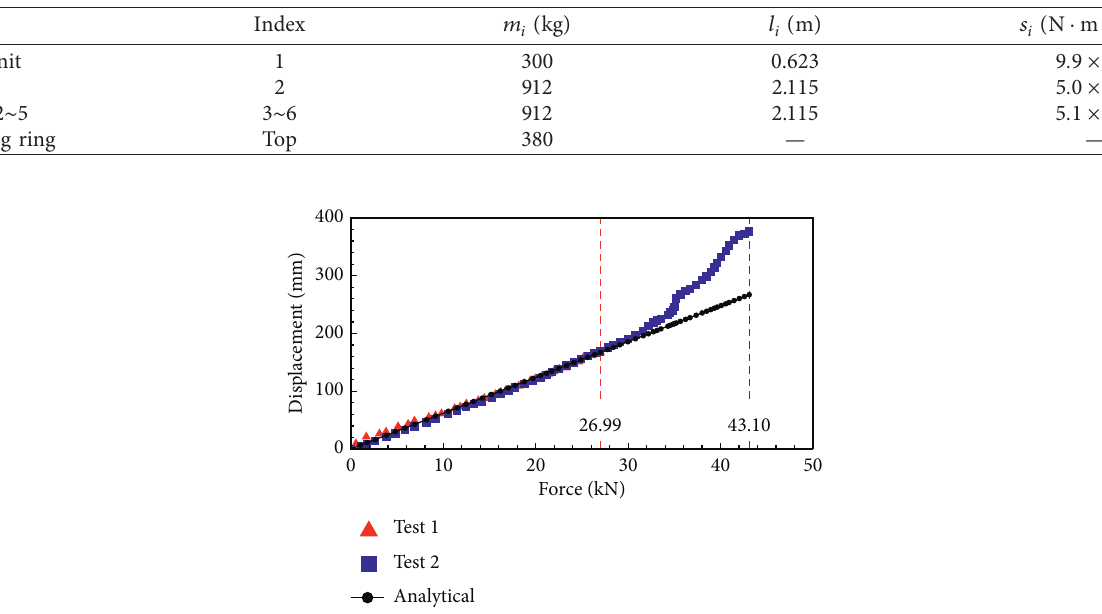
Figure 11: Force-displacement relationship at the top free end of the arrester specimen.